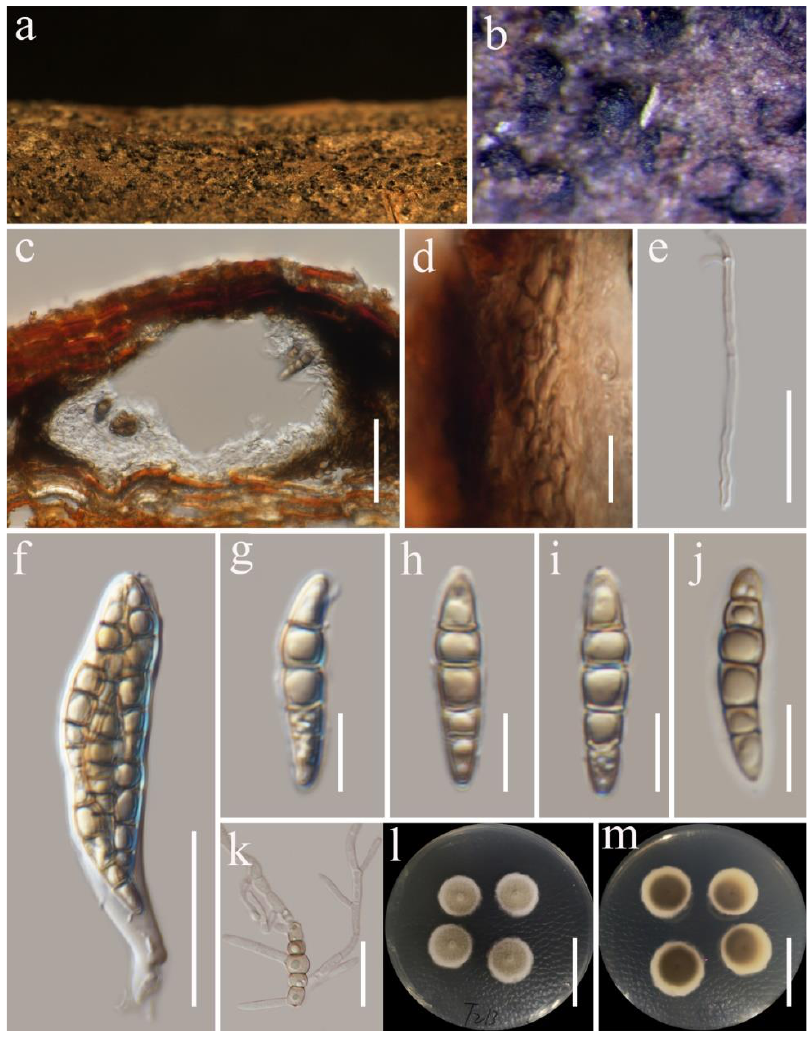
Figure 2. Septofusispora thailandica (MFLU 22-0043, holotype). ( a , b ) Appearance of ascomata on host substrate; ( c ) section of ascoma; ( d ) peridium; ( e ) hamathecium; ( f ) asci; ( g – j ) ascospores; ( k ) germinated ascospore; ( l , m ) culture characters on PDA ( l from above, m from below). Scale bars, ( c ) 50 µ m; ( d , e , k ) 20 µ m; ( f ) 30 µ m; ( g – j ) 10 µ m; ( l , m ) 30